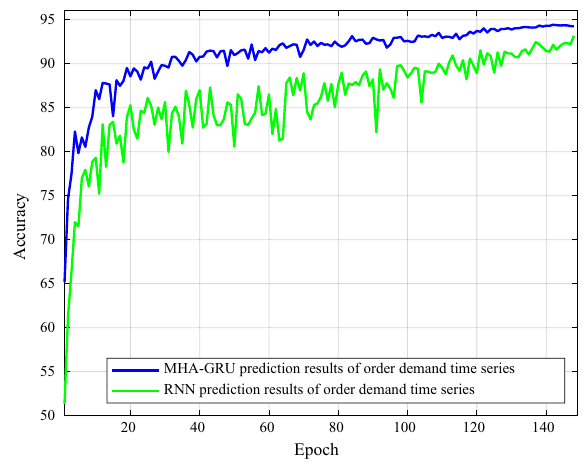
Fig. 10 Prediction accuracy of RNN and